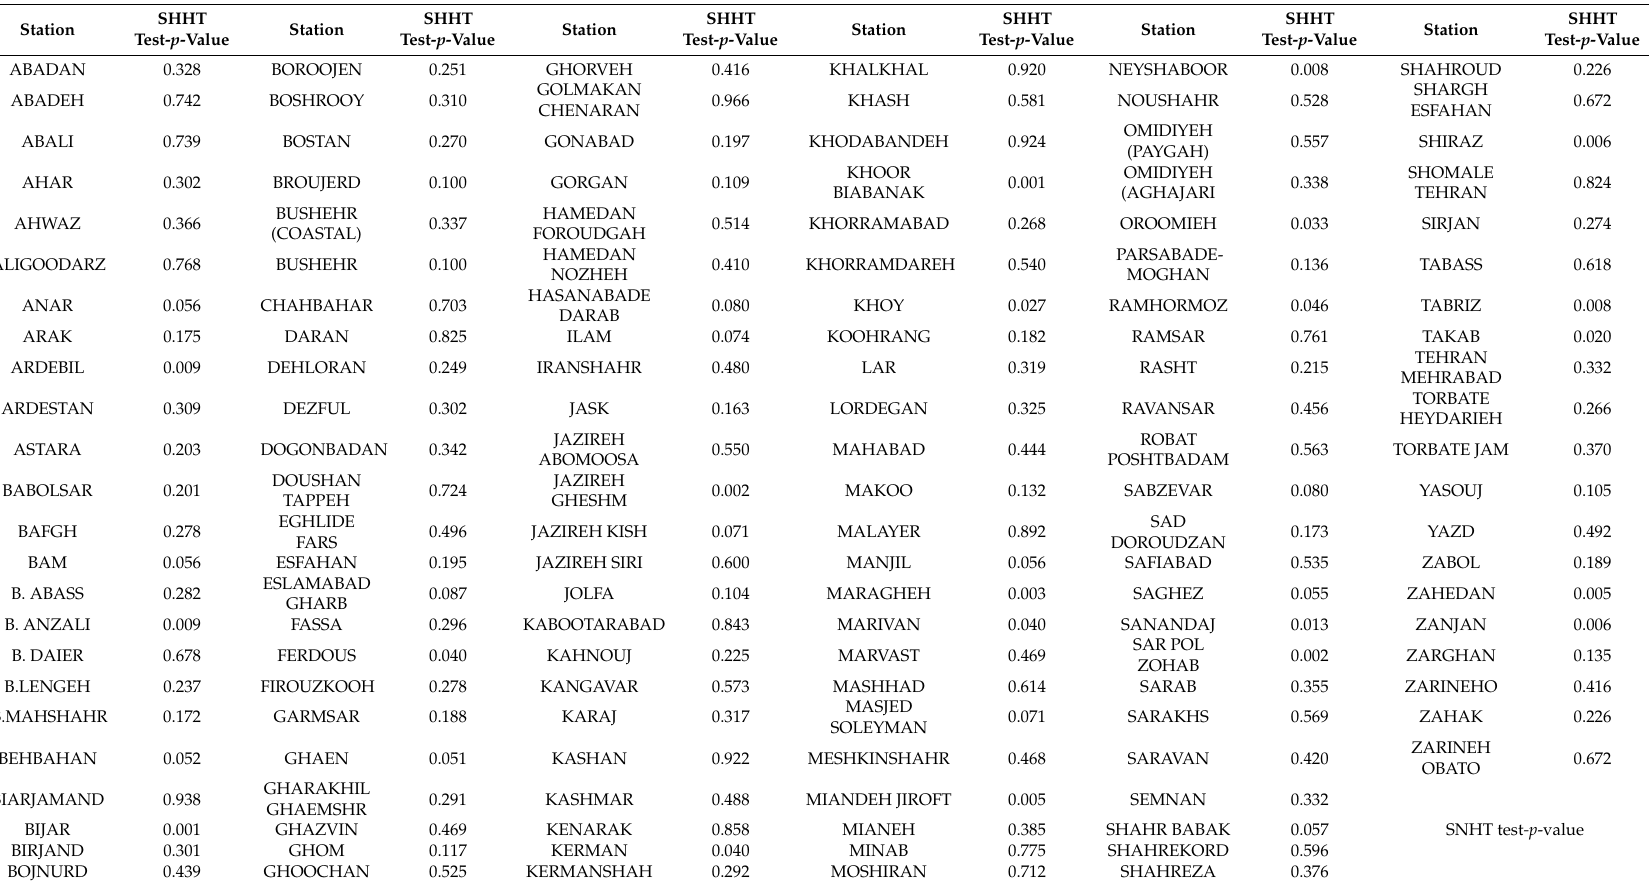
Table 2. Results of SHHT test for rainfall in